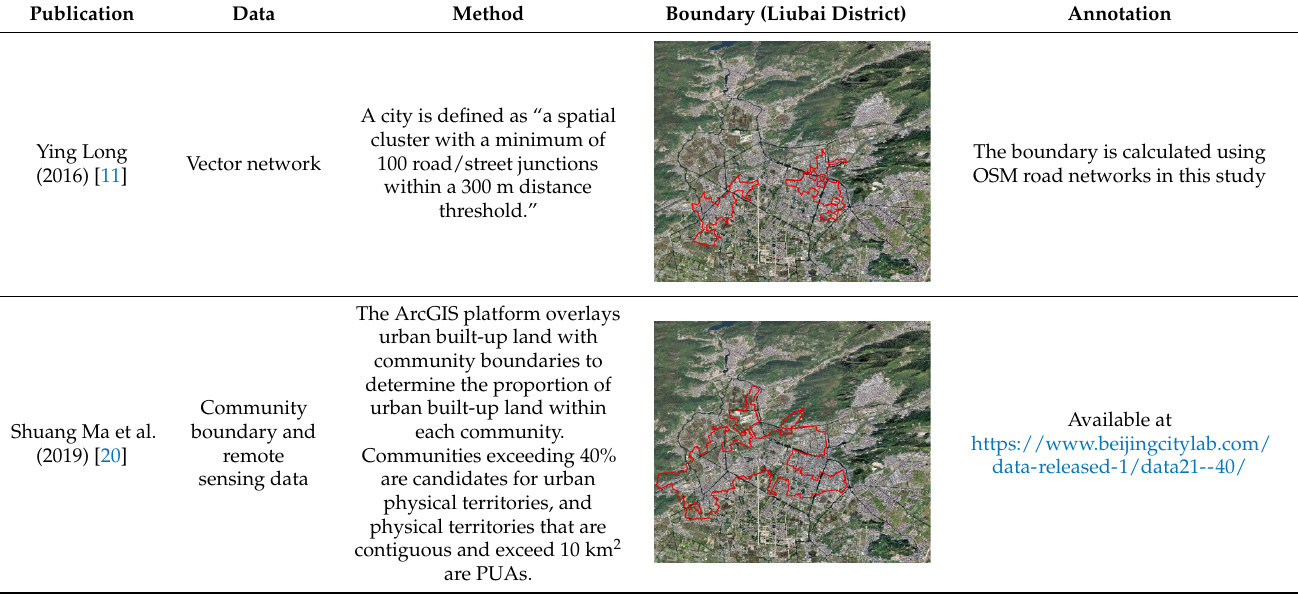
Table 1. Comparison of different PUB extraction methods.